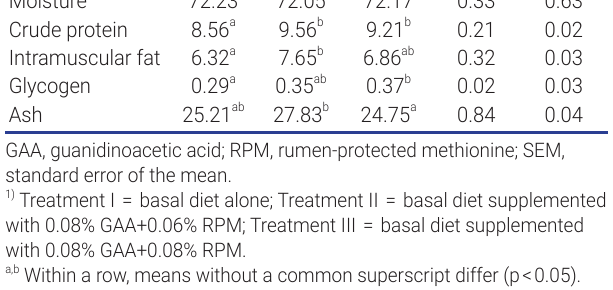
Table 4. Effect of dietary GAA and RPM supplementation on muscle nutritional composition of lambs (% fresh basis) Item